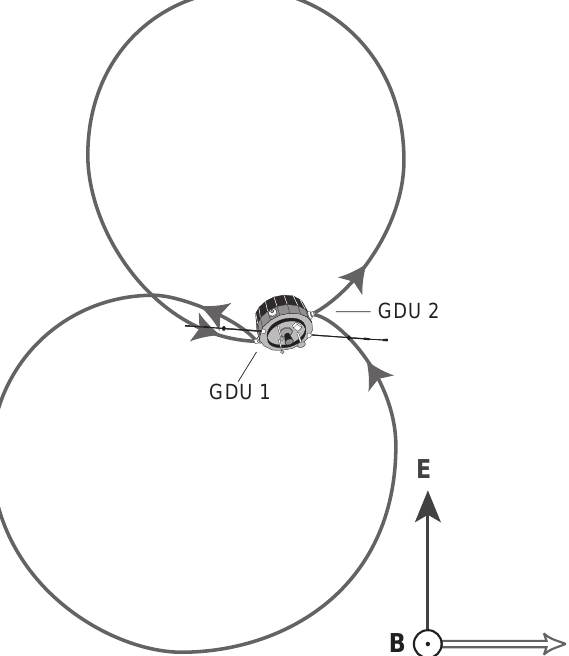
Fig. 1. EDI principle of operation. For any combination of magnetic field B and drift velocity v d (assumed to be induced by an electric field E ), only a single electron-trajectory exists that connects each gun with the detector on the opposite side of the spacecraft. The two trajectories have di(cid:128)erent path lengths and thus di(cid:128)erent times-of-flight. The drift velocity can be derived either from the two beam directions (triangulation technique), or from the di(cid:128)erence in the travel times of the electrons (time-of-flight technique). Note that for clarity the electron orbits are drawn for an unrealistic combination of v d and